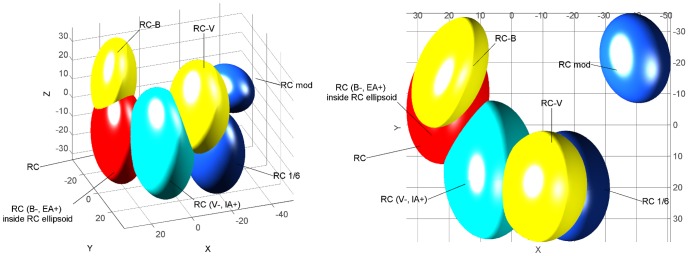
Human perception of RC mixtures varying in component's proportions.3D representations (2 different views) of the sensory map obtained from the free sorting task FS4 based on the sorting, by human adults of the RC mixture and several mixtures formulated as RC but with varying proportions of two components (RC(B−, EA+) and RC(V−, IA+) (light blue), equalized proportions of odorants at 16.7% (RC1/6, dark blue), redistributed components proportion (RCmod; dark blue), omission of odorant V or B (RC-V and RC-B, yellow). The map was drawn using a non-metric MDS analysis. Ellipsoids represent 95% confidence intervals and were calculated using a bootstrap algorithm.